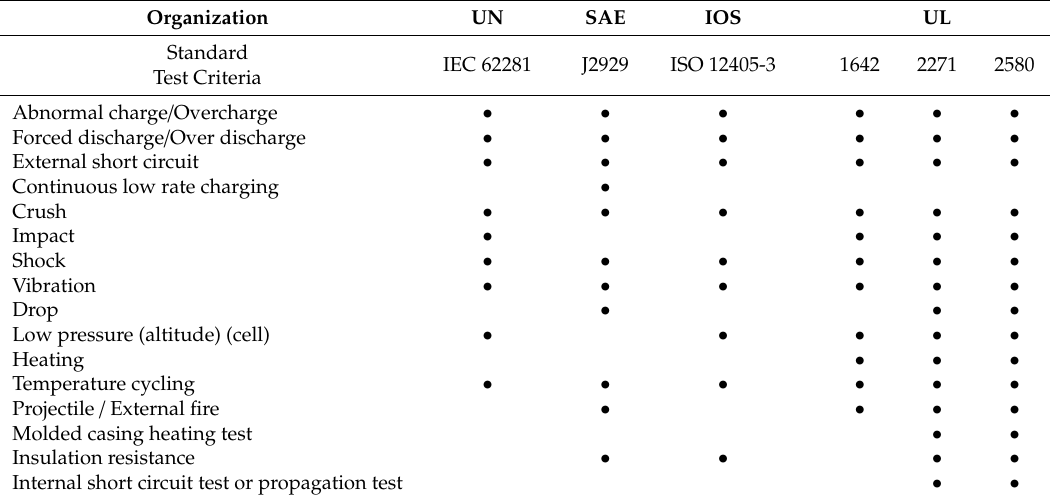
Table 7. List of selected standards for testing Li-ion